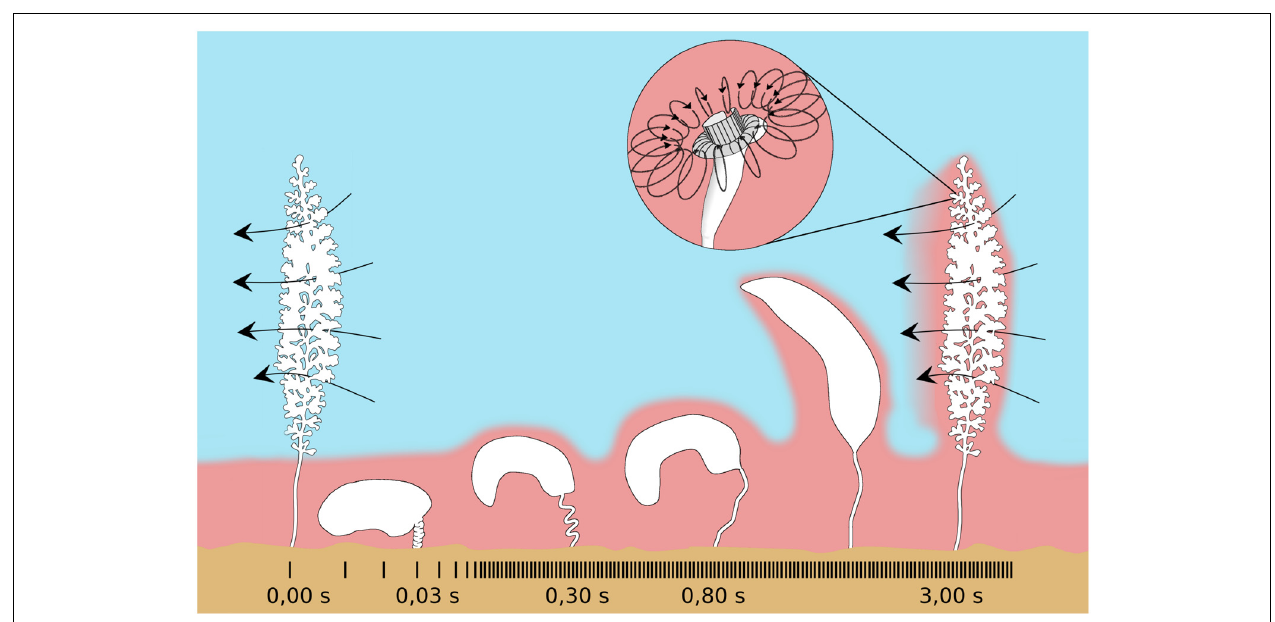
FIGURE 10 | Schematic drawing of the contraction pattern of Zoothamnium niveum . The fast contraction (520 mm s − 1 ) brings the colony in the sulfidic boundary layer (pink), then a slow extension movement bring it back to the oxygenated water (blue) dragging along sulfide from the boundary layer. Once extended, the cilia from the microzooids (insert) start beating again creating a toroidal vortex around the upper part of the cell